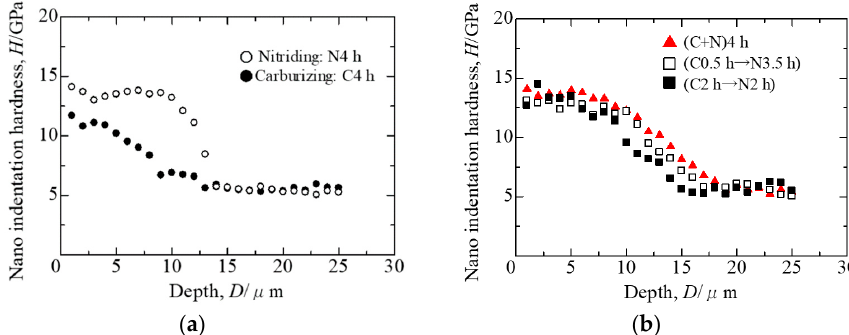
Figure 10. Hardness depth profiles of the S-phase layers on cold-sprayed AISI 316L coatings obtained at 450 ◦ C by ( a ) single carburizing and nitriding treatments and ( b ) combined plasma